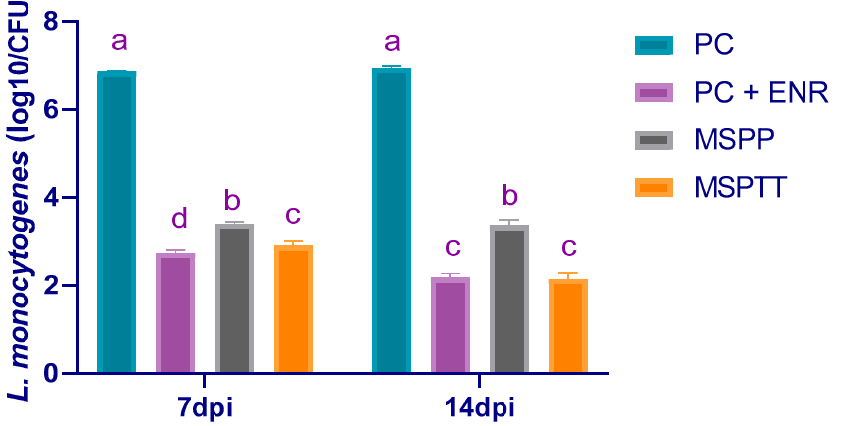
Figure 7. Quantification of cecal L. monocytogenes populations in response to multi-strain probiotics (either prophylactically and/or therapeutically) supplementation and enrofloxacin (ENR) at 7- and 14-days post-infection (dpi), as measured by real-time PCR assay. MSP: multi-strain probiotics in- cluding Lactobacillus acidophilus NBIMCC 8242, Bacillus subtilis DSM 17,299, and Enterococcus faecium NBIMCC 8270. PC: positive control (rabbits fed a basal diet and experimentally infected with L. monocytogenes ); PC+ENR: rabbits fed a basal diet, experimentally infected with L. monocytogenes, and treated with enrofloxacin; MSPP: rabbits fed a basal diet supplemented with MSP at the level of 1 × 10 8 CFU/kg from 30 to 60 days of age and experimentally infected with L. monocytogenes ; MSPTT: rabbits fed a basal diet supplemented with MSP at the level of 1 × 10 8 CFU/kg from 30 to 90 days of age and experimentally infected with L. monocytogenes . Rabbits were orally administered with L. monocytogenes at the concentration of 10 7 CFU/mL at 60 days of age Values are means with their SE in bars. a–d : Means inside the same column having different superscripts are significantly different at p < 0.05. 3.5. Histopathological Alterations At 14-days post-infection, the liver of L. monocytogenes experimentally-infected rab- bits (positive control group) showed congestion of the hepatic blood vessels and sinus- oids. Moreover, thrombus was formed within blood vessels and neutrophilic infiltrations were seen within sinusoids. The brain showed suppurative meningitis, which is charac- terized by an increase in the thickness of the meninges due to meningeal congestion and leukocytic infiltrations, mainly neutrophils. The spleen showed shrinkage of some lym- phoid follicles and necrotic changes of some lymphoid elements besides dilated splenic sinusoids (Figure 8a). The histopathological findings of rabbits experimentally infected with L. monocytogenes and treated with enrofloxacin are shown in Figure 8b. The liver showed a preserved lobular pattern, cord arrangement, central veins, and portal triads structures with the presence of thrombus in the blood vessels and neutrophilic infiltra- tions within sinusoids in the hepatic parenchyma. The brain tissue showed abundant cel- lular and karyorrhectic debris of inflammatory cells within periventricular tissue with ventricular congestion, edema, and necrosis of some choroid plexus epithelium. The ex- amined sections of the spleen showed depleted lymphocytes within some white pulp. Ad- ditionally, the histopathological outcomes of the liver, brain, and spleen of rabbits that received a diet supplemented with MSP as a prophylactic and experimentally infected with L. monocytogenes (MSPP) are shown in Figure 8c. The examined liver section tissues showed normal hepatic cords and blood vessels with prominent kupffur cells. Most of the cerebral parenchyma had normal structures. However, the periventricular inflammatory cells were seen. The spleen revealed mild to moderate proliferation of the white pulp lym- phoid population. The red pulp showed congestion of splenic blood vessels and it was infiltrated by a large number of mature and immature lymphocytes and proliferated mac-